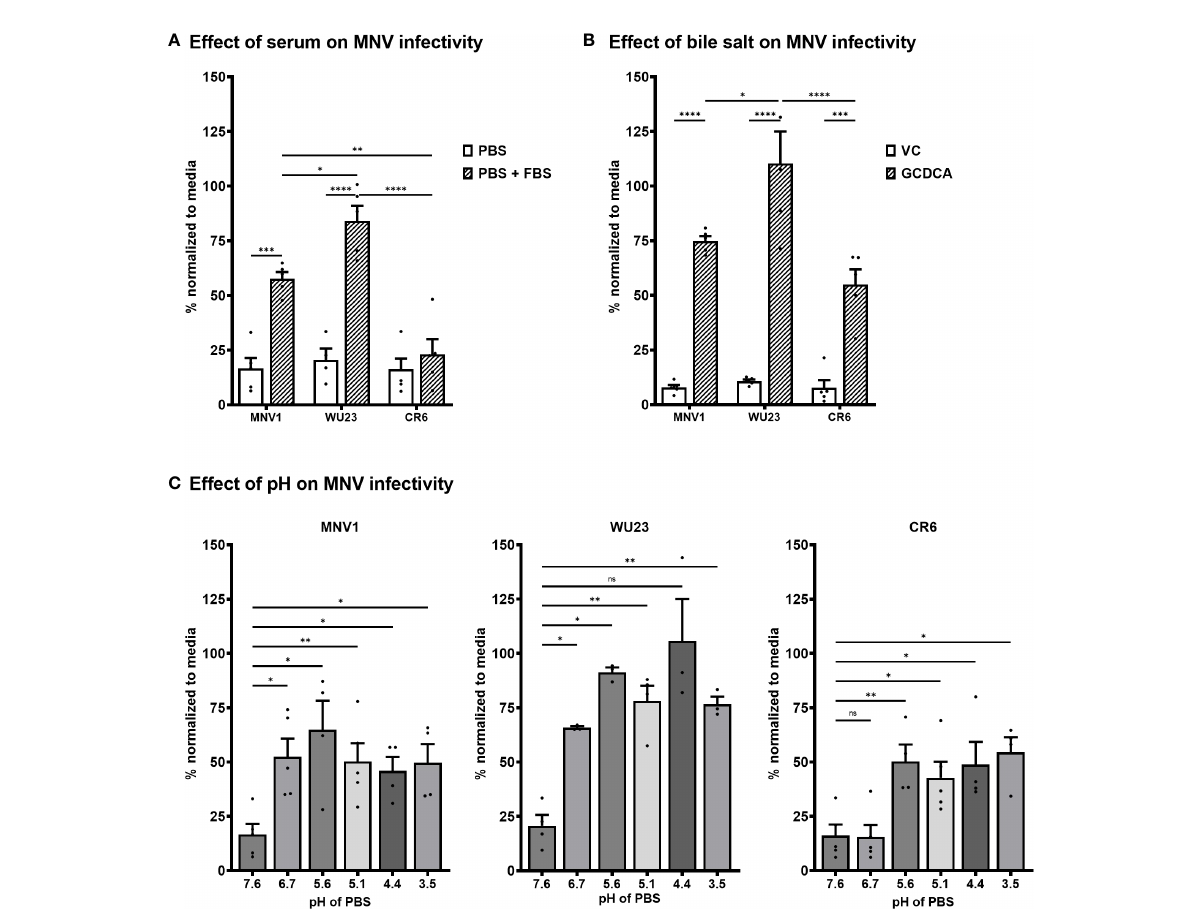
FIGURE 5 Diarrheagenic MNV1 and WU23 are enhanced by a broader pro fi le of environmental triggers than attenuated CR6. (A) BV2 cells were infected with 100 TCID 50 units per well of MNV1, WU23, or CR6 in neutral PBS, pH 7.6 or PBS supplemented with 10% FBS. Virus titers were determined by plaque assay at 2 dpi and normalized to viral titers following infection in media. P values were determined using ANOVA with Sidak ’ s multiple comparisons test. (B) BV2 cells were infected with 100 TCID 50 units per well of MNV1, WU23, or CR6 250 m M GCDCA resuspended in EtOH or vehicle control (VC). Virus titers were determined by plaque assay at 2 dpi and normalized to viral titers following infection in media. P values were determined using ANOVA with Sidak ’ s multiple comparisons test. (C) BV2 cells were infected with 100 TCID 50 units per well of MNV1 (left panel), WU23 (middle panel), or CR6 (right panel) in PBS at the indicated pH. Virus titers were determined by plaque assay at 2 dpi and normalized to viral titers following infection in media. P values were determined using ANOVA with Dunnett ’ s multiple comparisons test using pH 7.6 as the control group. At least three independent experiments were performed for all experiments. *P < 0.05, **P < 0.01, ***P < 0.001, ****P < 0.0001, ns, not signi fi